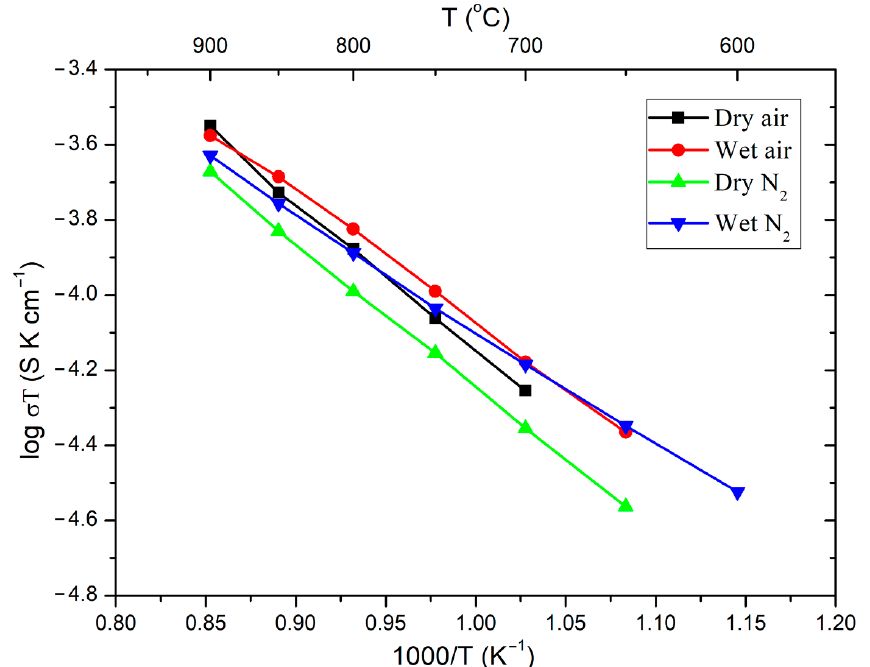
Figure 5. Total conductivity of La 2 (Hf 1.9 La 0.1 )O 6.95 in dry and wet air and N 2